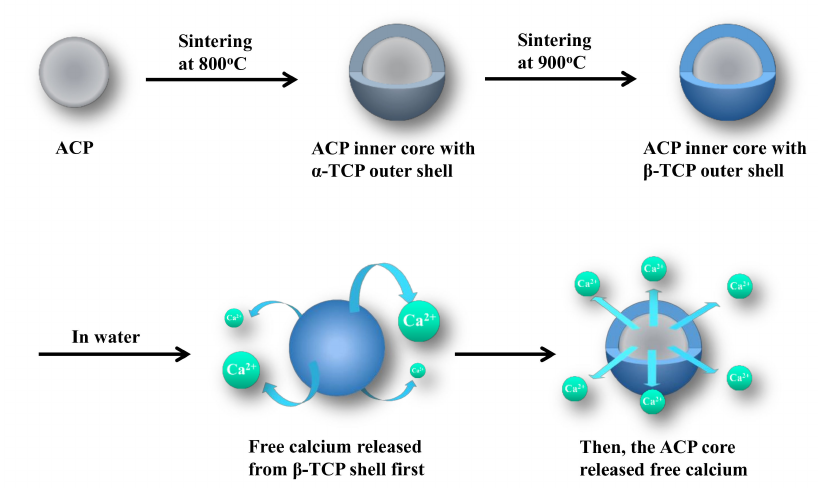
Figure 6. The proposed mechanism of free calcium release from core–shell-structured